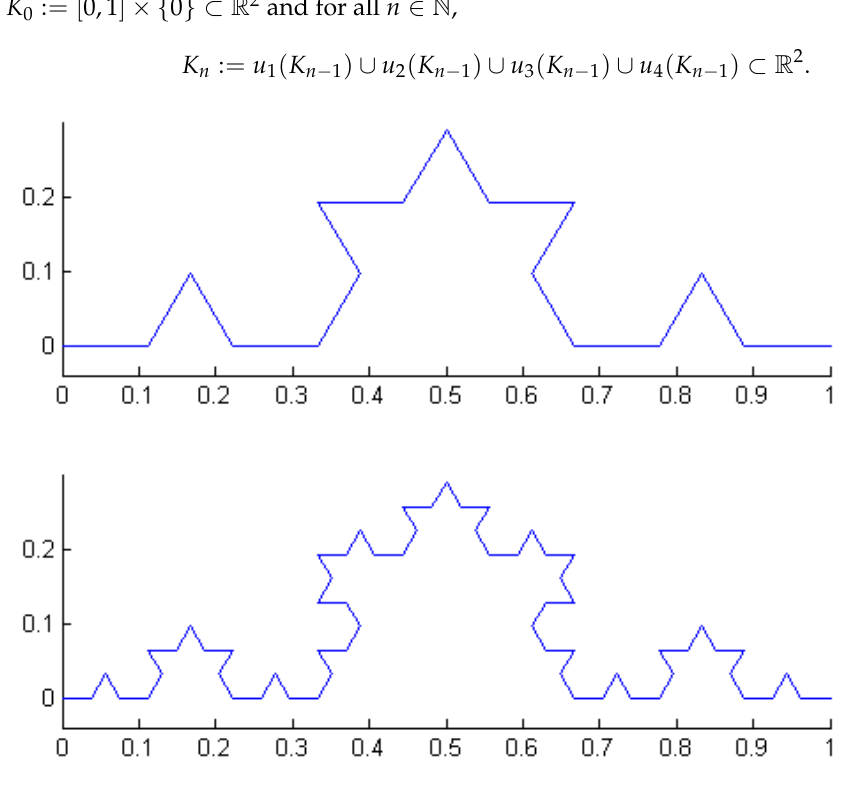
Figure 1. K 2 and K 3